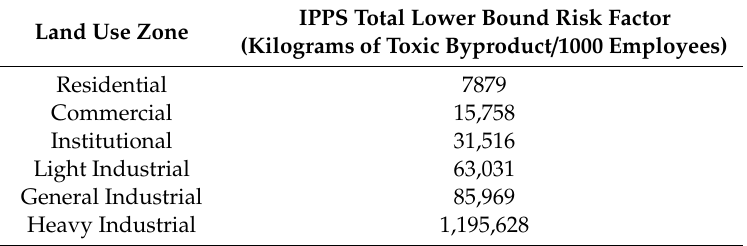
Table 1. Zone-based extrapolated hazard